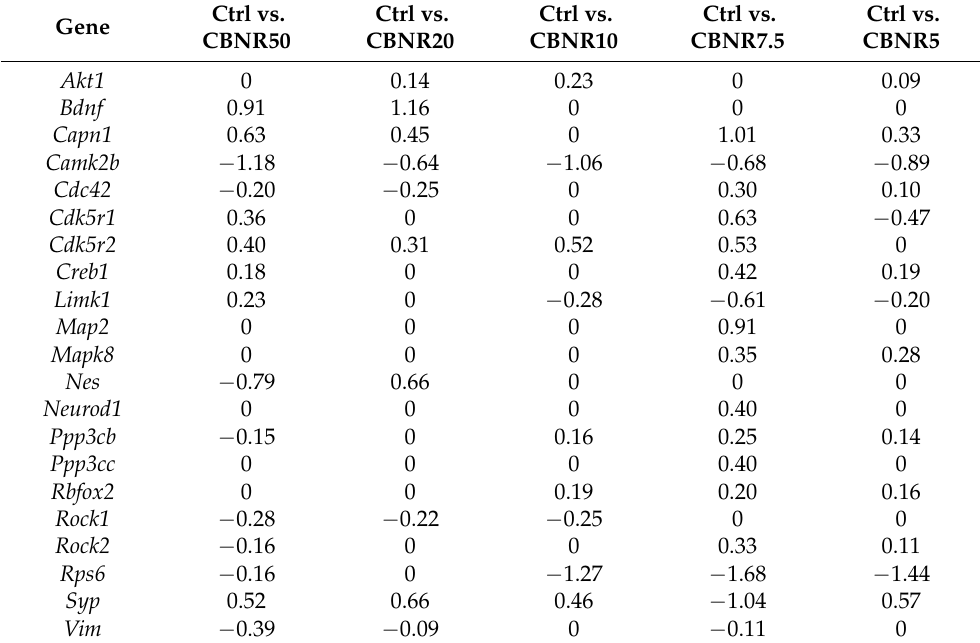
Table 1. DEGs involved in neurogenesis/differentiation. Ctrl vs. Ctrl vs. Gene